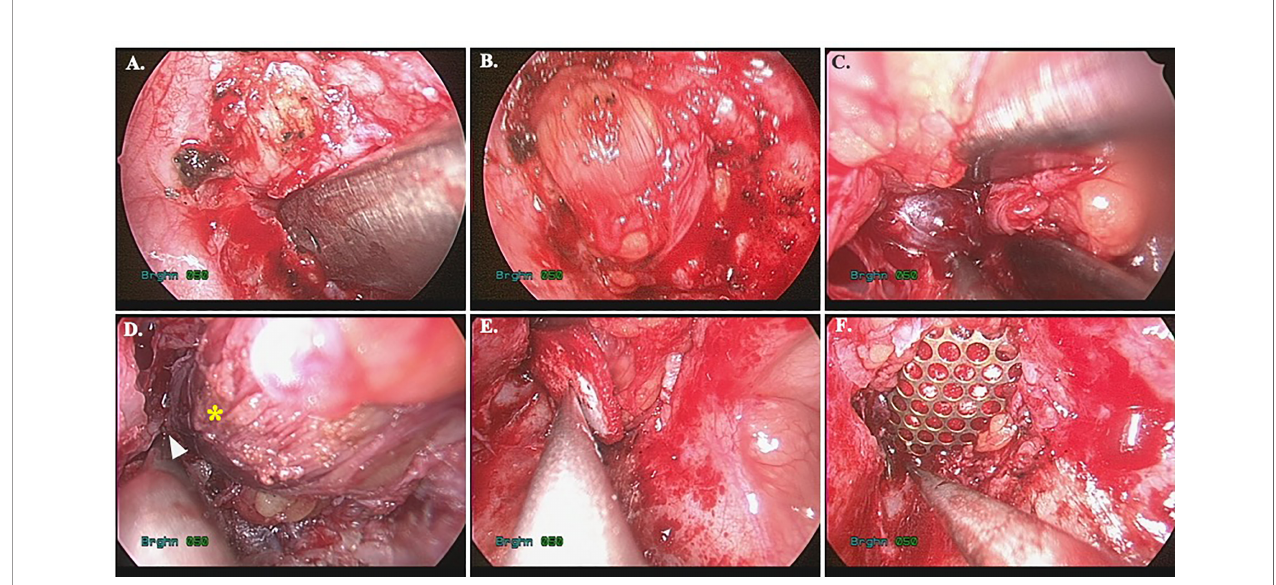
FIGURE 4 | Image-controlled surgical excision of medial orbital tumor with reconstruction. (A) entry of the medial orbit; (B) periorbita and inferior rectus muscle; (C) identify the tumor; (D) image after tumor excision, the arrowhead: ethmoid sinus, star: medial rectus muscle; (E) bio-collagen membrane repair of the defect; (F) Ti-mesh reinforcement of the inferomedial